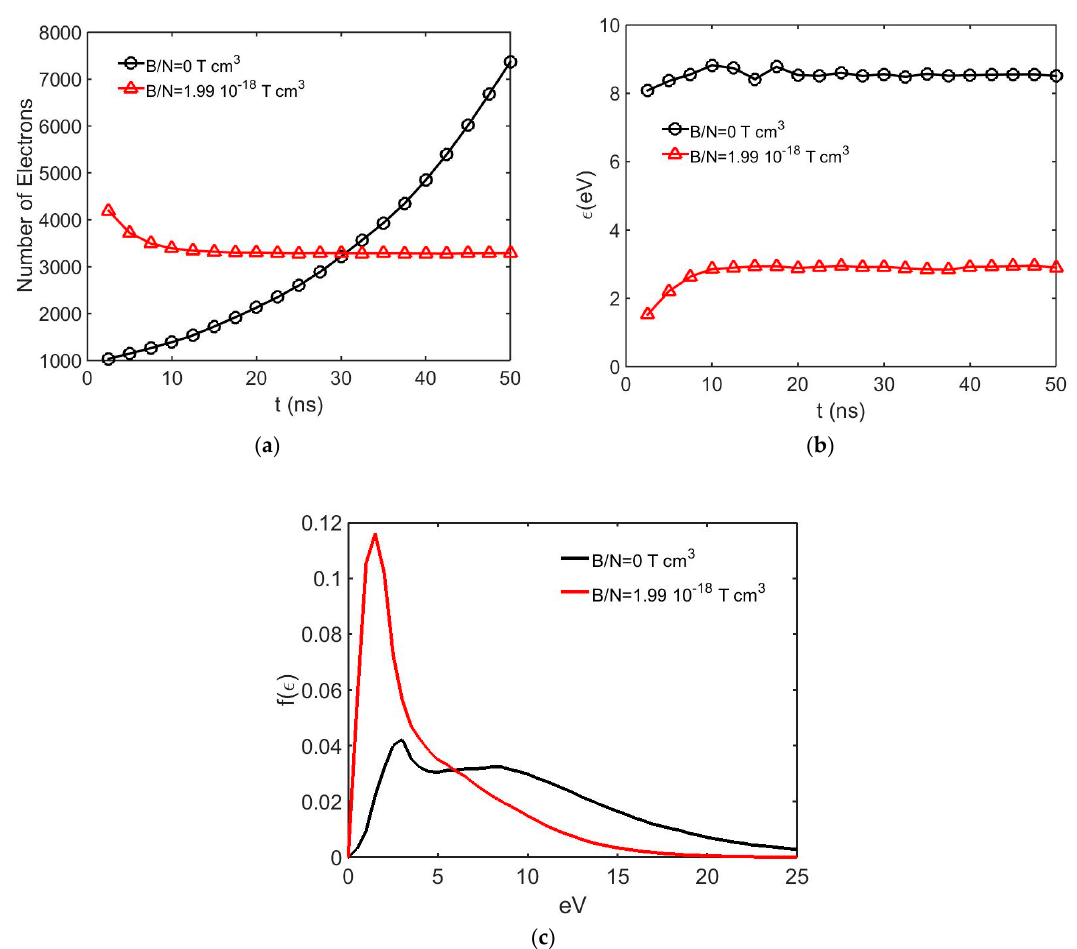
Figure 10. A 0.75% SF 6 + 99.25% N 2 mixture at 400 Td with different magnitudes of crossed magnetic field: ( a ) number of electrons; ( b ) electron mean energies; ( c ) electron energy distribution functions (Corresponding magnetic field strength; Black line: H = 0 A/m, Red line: H = 5.26 × 10 4 A/m).